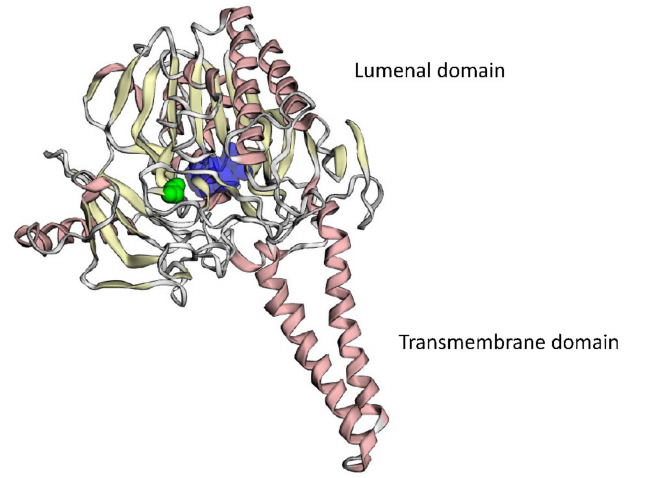
Figure 5. 3D modeling of the mutant STS protein. Ca 2+ -binding cavity is colored dark blue, mutant amino-acid residue, p.G370A, is colored